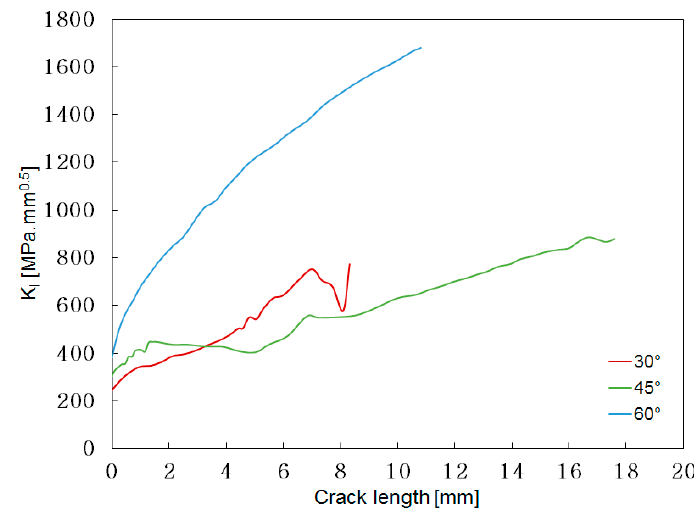
Figure 22. Comparison of the different flank angles at 95% crack front for the short flank design option: KI stress intensity factor.